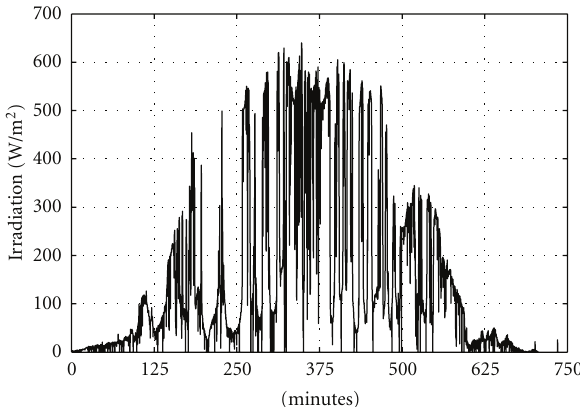
Figure 3: Solar radiation intercepted during daylight.